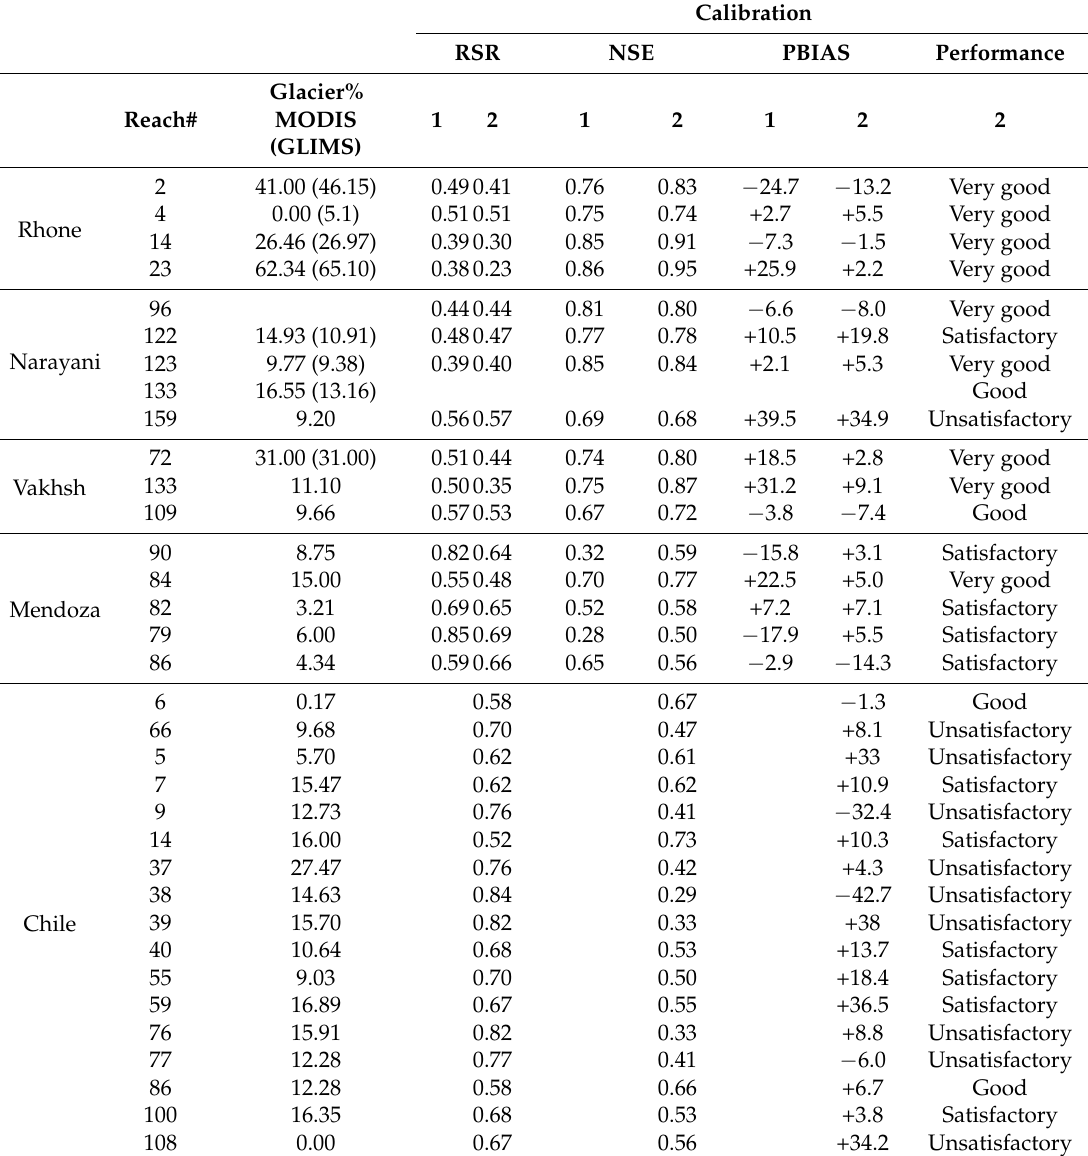
Table 8. Model performance by both lumped and modified snow algorithms for calibration